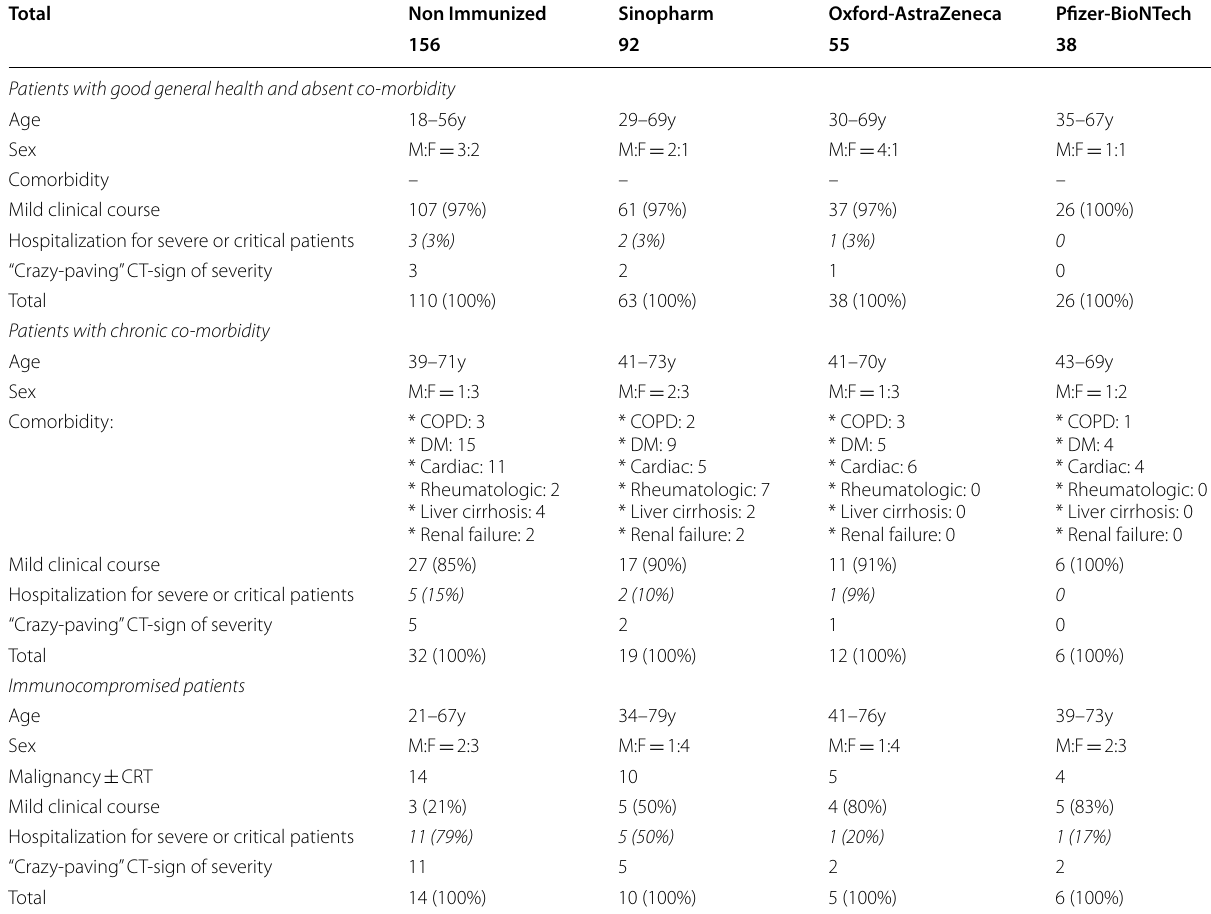
Table 1 Demographic results, types of comorbidities and severity classifications in each group of patients Total Patients with good general health and absent co-morbidity